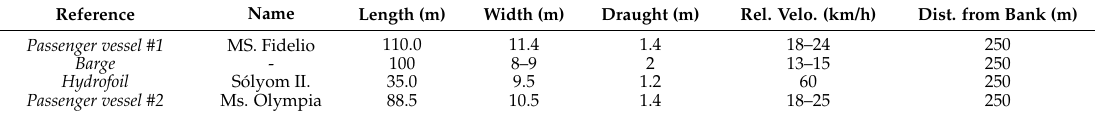
Table 1. Detailed information on the different ship parameters for the investigated